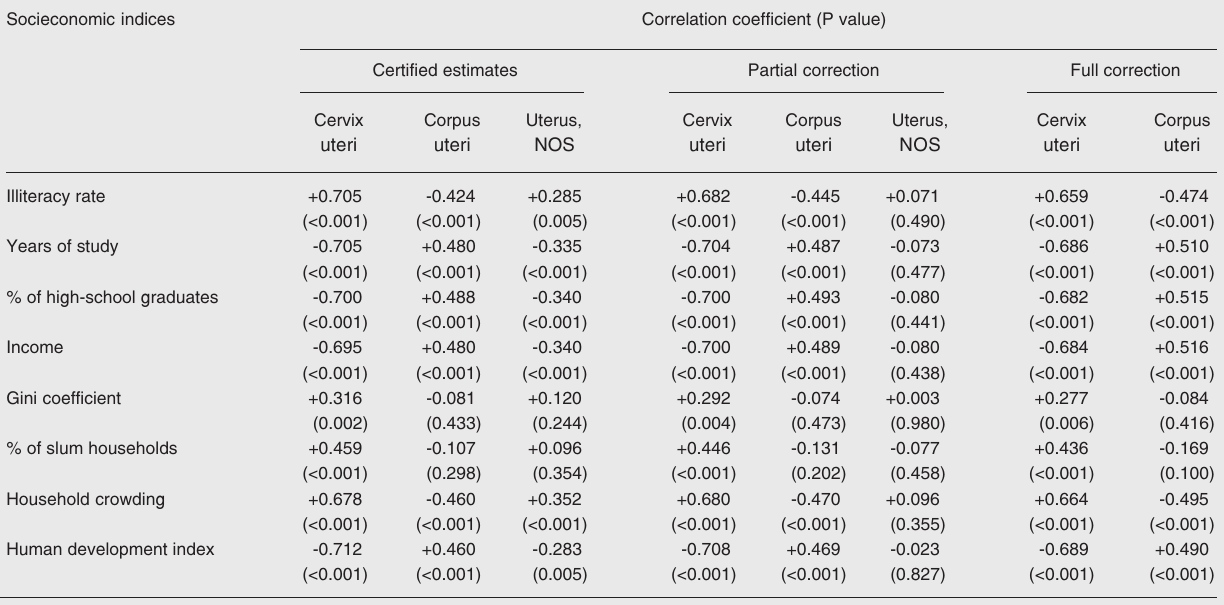
Table 2. Goodness-of-fit assessment (Spearman correlation coefficient and P values) of the area-level association between socioeconomic indices and categories of uterine cancer mortality in São Paulo, Brazil, 1995-2003. Socieconomic